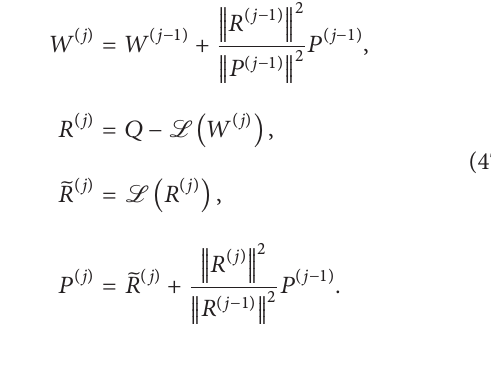
Algorithm 11 (modified conjugate gradient